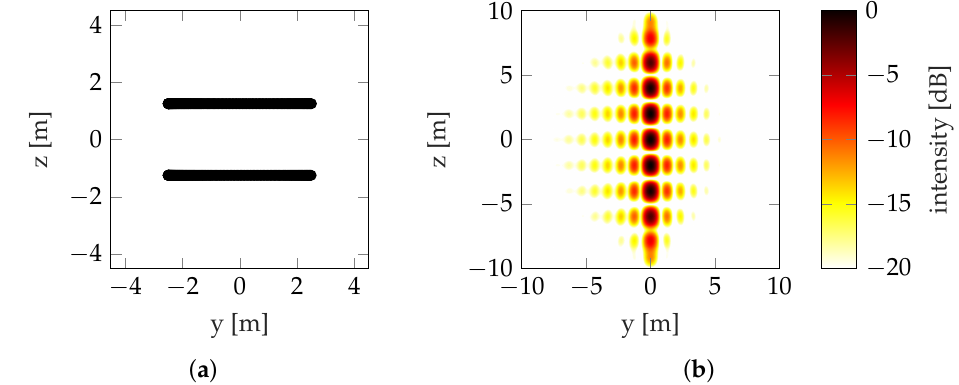
Figure 19. Reference scenario with two passes: ( a ) Trajectory. ( b )